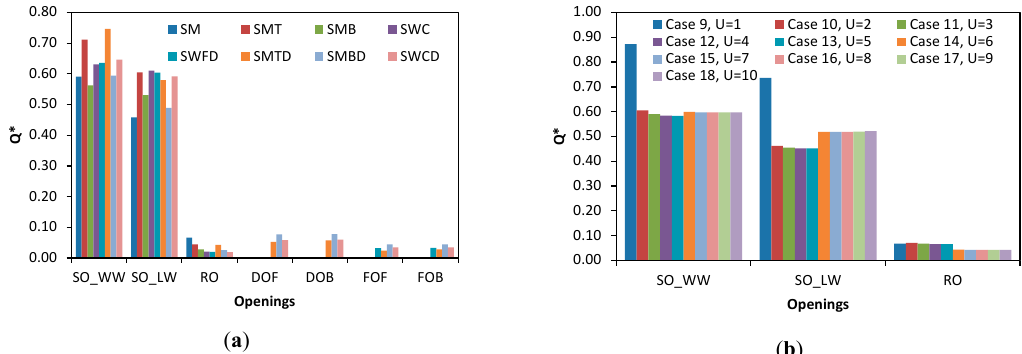
Figure 13. Non-dimensional airflow rate ( Q* ) at the different openings of NVD building for ( a ) Case 1 to Case 8 with same reference velocity U ref = 4.41 m ∙ s -1 and ( b ) Case 9 to Case 18 for different inlet velocity ( U ) 1 to 10 m ∙ s -1 ; where SO_WW—Side wall opening in windward side, SO_LW—Sidewall opening at leeward side, RO—Roof opening, DOF—Doors opening in the front gable wall, DOB— Doors opening in the back gable wall, FOF—Feeding alley opening in the front gable wall, and FOB— Feeding alley opening in the back gable wall. U value in the legend indicates inlet velocity in m ∙ s -1 .